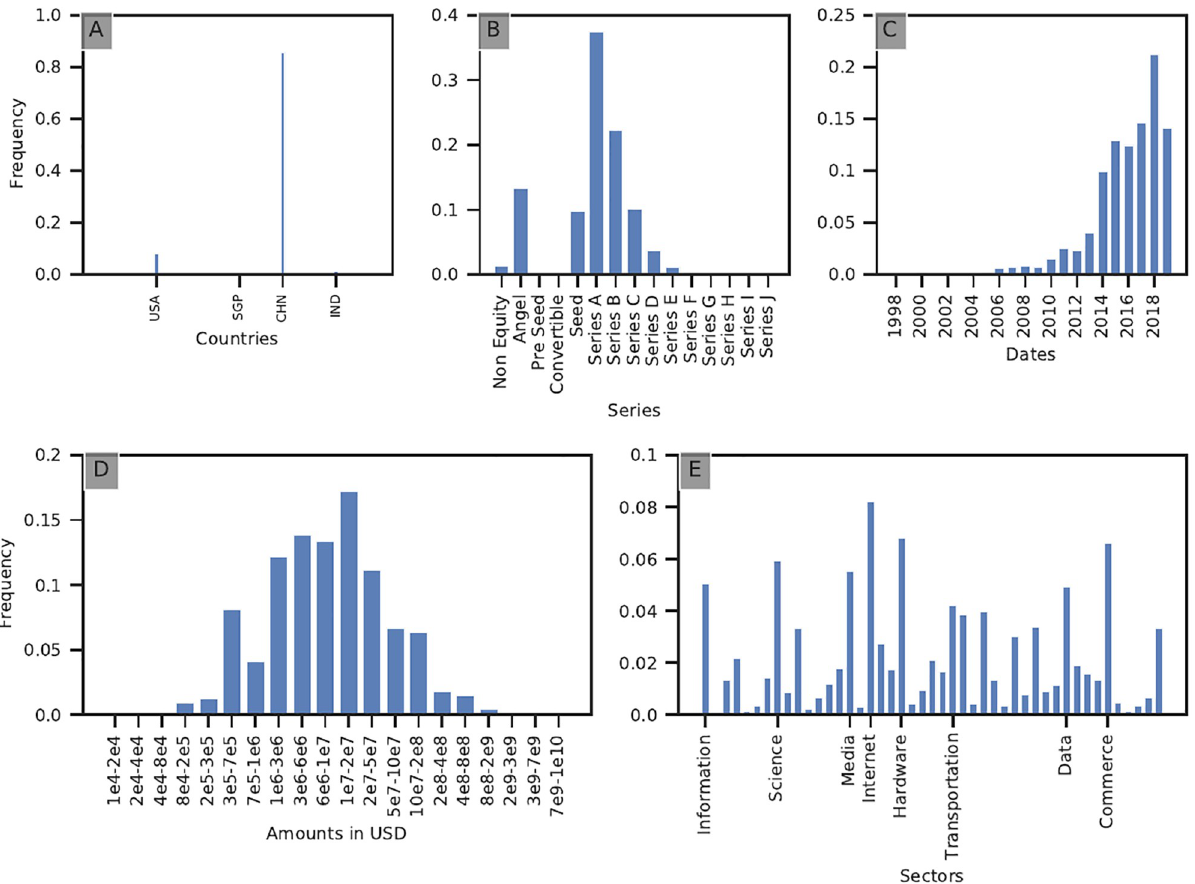
Fig 7. Representative investor of community A6. Community A6 appears comprised of investors targeting China-based ventures during the second half of the 2010s with no clear sectoral specialization. Panel A shows the representative geographical investment distribution of community A6 , panel B the distribution of the series of investment, panel C the temporal distribution of investments, panel D the distribution of the amounts of investment and panel E shows the sectoral distribution of